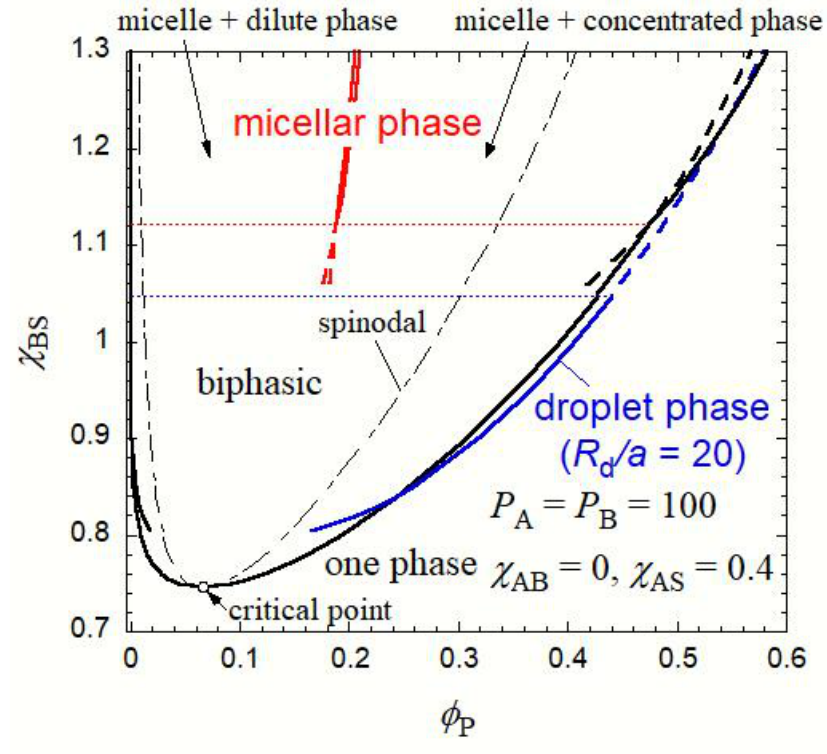
Figure 3. Phase diagram of the AB diblock copolymer solution with P A = P B = 100 ( x A = x B = 0.5), χ AS = 0.4 and χ AB = 0. χ AS = 0.4 and χ AB =